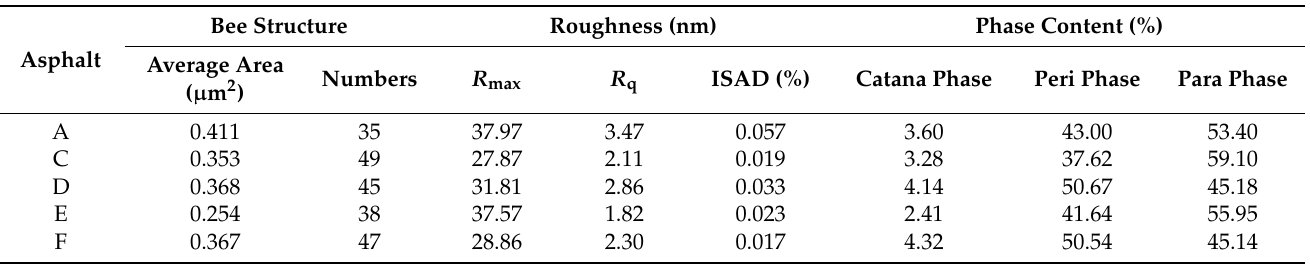
Table 2. Morphology parameters of tested asphalt